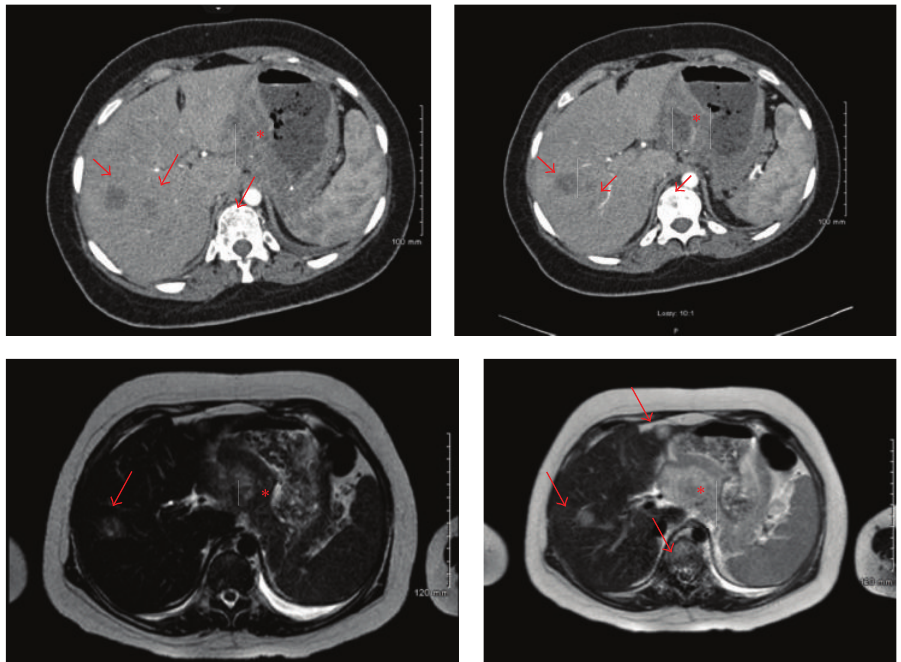
Figure 1: Incidental finding of thickening of stomach lining (asterisk), multiple liver and spinal metastases (arrows) found in the CT with contrast angiogram of the chest.